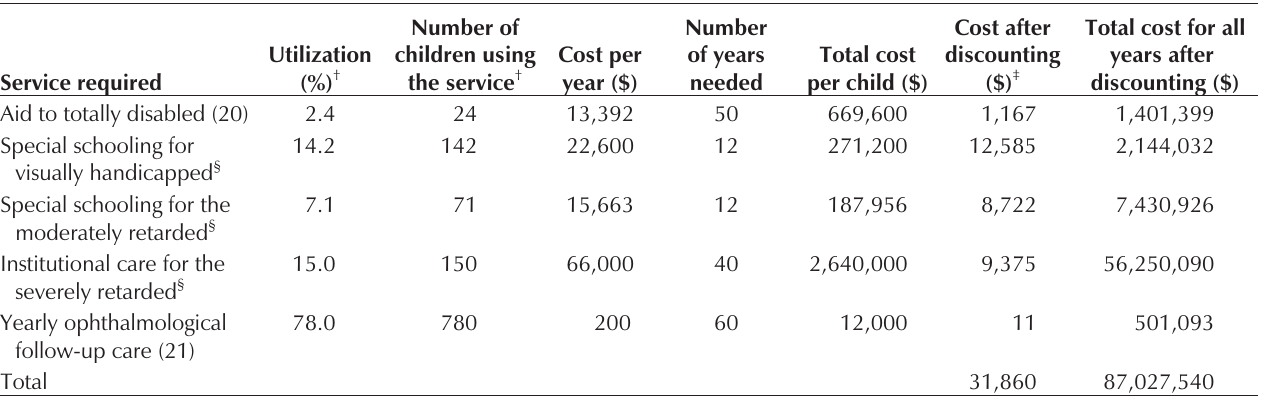
Lifetime cost of special services for 1000* children with congenital toxoplasmosis born in Canada each year